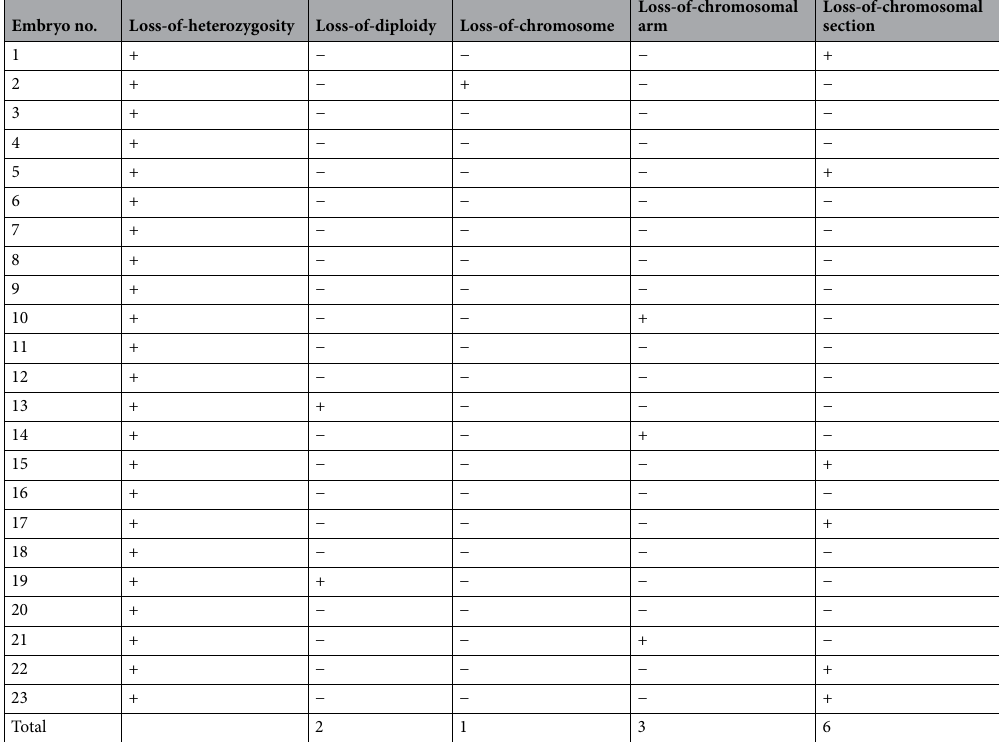
Table 3. Rationale of Loss-of-heterozygosity of embryos showing homozygous biallelic editing. Classification of embryos (n = 23) identified to represent homozygous full edits based on Loss-of-heterozygosity pattern as determined by proportion of SNP-heterozygosity considering subsequent DNA windows. Of these embryos, 2 showed complete Loss-of-heterozygosity in every chromosome and were classified as being Loss-of-diploidy. Of the remaining ones a total of 11 embryos were classified as non-disrupted. Conversely 1 embryo was classified as Loss-of-chromosome, 3 embryos were classified as Loss-of-chromosomal arms and 6 Embryos were classified as Loss-of-chromosomal section. Details of all embryos can be checked in Suppl. Fig.